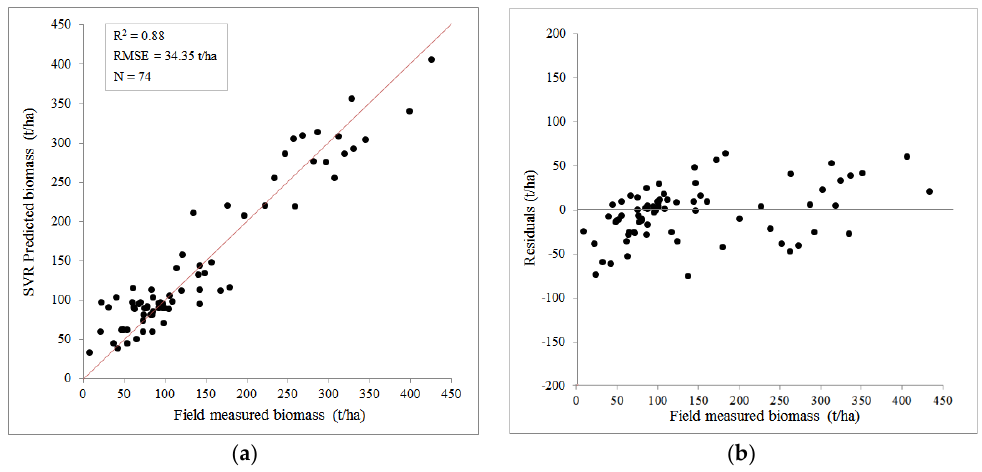
Figure 5. Field-measured AGB and the SVR-predicted AGB. ( a ) Scatter plot for the correlation between field-measured AGB and SVR-predicted AGB; ( b ) the residuals between field-measured AGB and SVR-predicted AGB. The red line represents the 1:1 correspondence line. Remote Sens. 2016 , 8 , 230